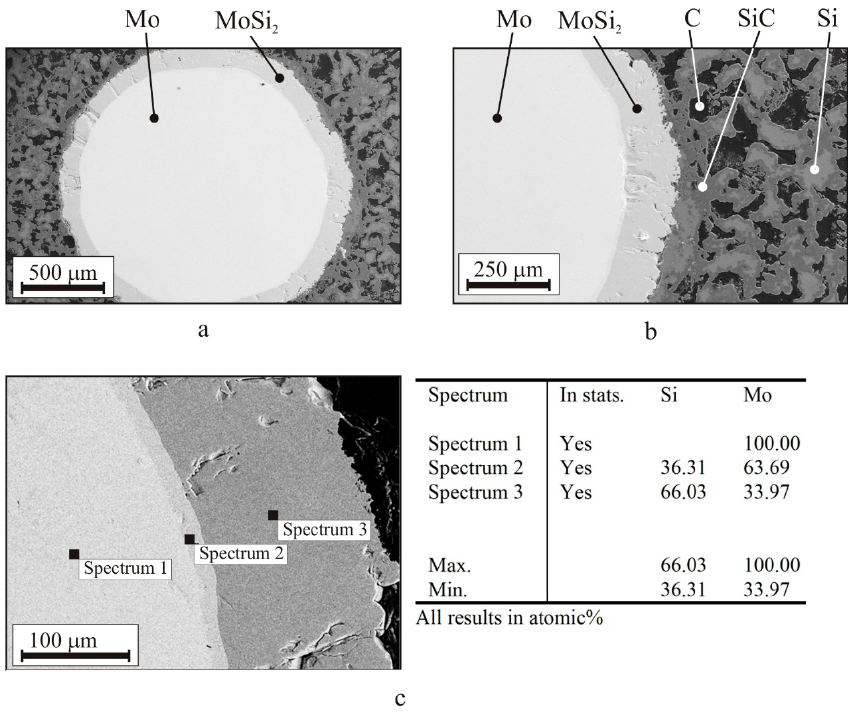
Figure 5. ( a , b ) Microstructure of SiC-based ceramic with Mo wire; ( c ) phase analysis of the metal–silicide interface.